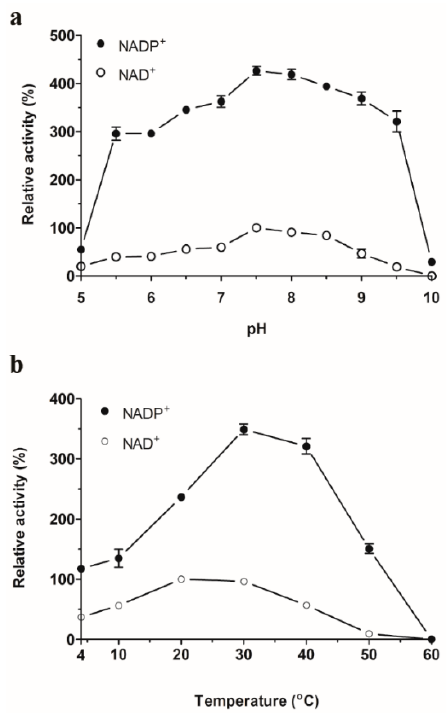
Figure 3. Apparent optimum pH and temperature of SpG6PD1. ( a ) Effect of pH: SpG6PD1 activity was measured at a range of pH between 5.0–10.0, for 2 min at 30 ◦ C. 100% = 27.6 µ M · min − 1 . ( b ) Effect of temperature: SpG6PD1 activity was evaluated in the reaction mixture at various temperatures, from 4–60 ◦ C for 2 min. 100% = 32.1 µ M · min − 1 . Data correspond to the value ± SD of three independent experiments.